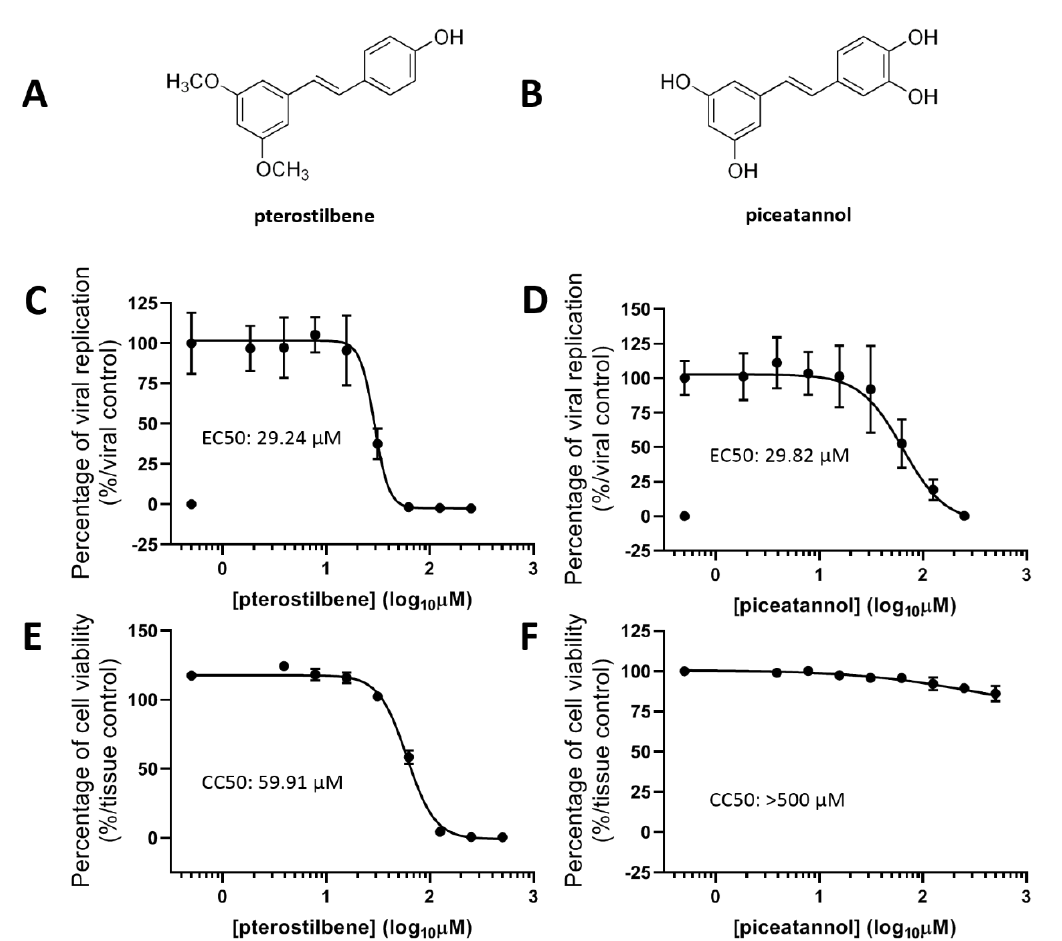
Figure 7. EC50 and CC50 of resveratrol derivatives against VEEV. Pterostilbene (panel A ) and piceatannol (panel B ) were used to treat VEEV-TC-83luc (MOI = 0.1)-infected Vero cells at indicated concentrations, followed by measurement of EC50 by viral luciferase activity at 16 h post-infection ( C , D ). CC50 values were determined ( E , F ) via quantifying cellular ATP levels. The figures were plotted following the normalizing toward tissue or viral control groups.